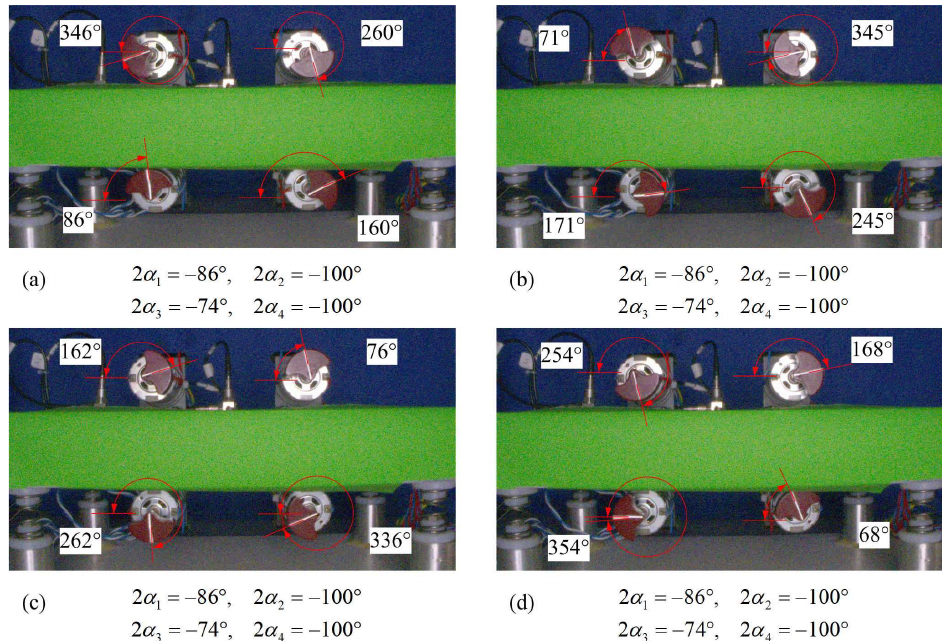
Figure 7. Phase differences of ERs change from locities of four ERs; ( b ) Phase differences; ( c ) Acceleration amplitude in y direction at 20 s and 40 s; ( d ) Acceleration amplitude in x direction at 20 s and 40 s.